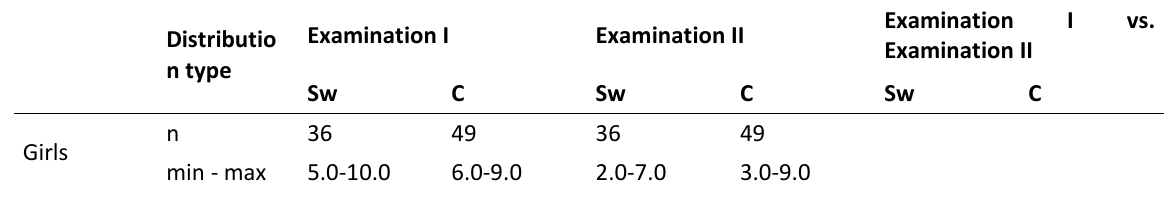
Table 2. Descriptive characteristics of Flamingo Balance Test (general balance) in the Swimmers and Control